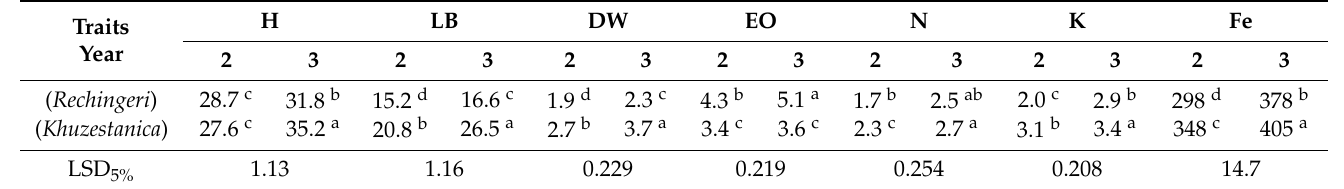
Table 6. Mean comparisons for interaction effects of year × species for some savory traits.